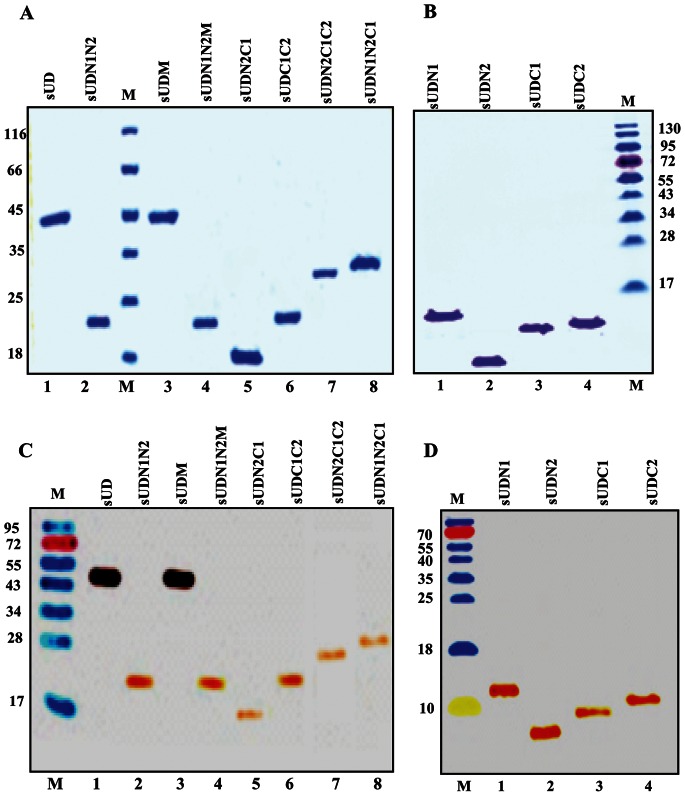
SDS PAGE and Western blot analysis.A and B. Coomasie blue stained gel. Lane M in A and B are protein molecular weight markers and the proteins loaded in each lane are written on top of the gels. C and D. Western blot analysis. Lane M in C and D are protein molecular weight markers and the proteins loaded in each lane are written on top of the gel.